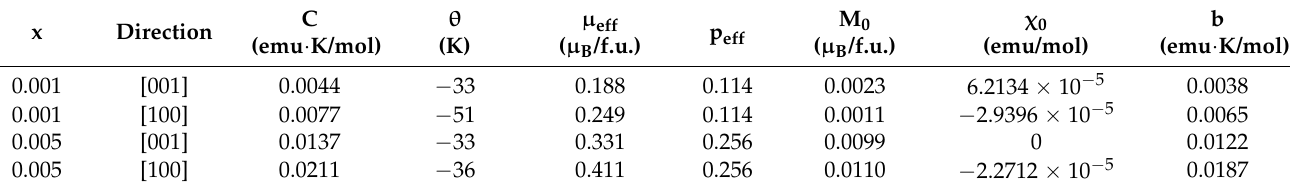
Table 1. Magnetic parameters of PNMWO single crystals.